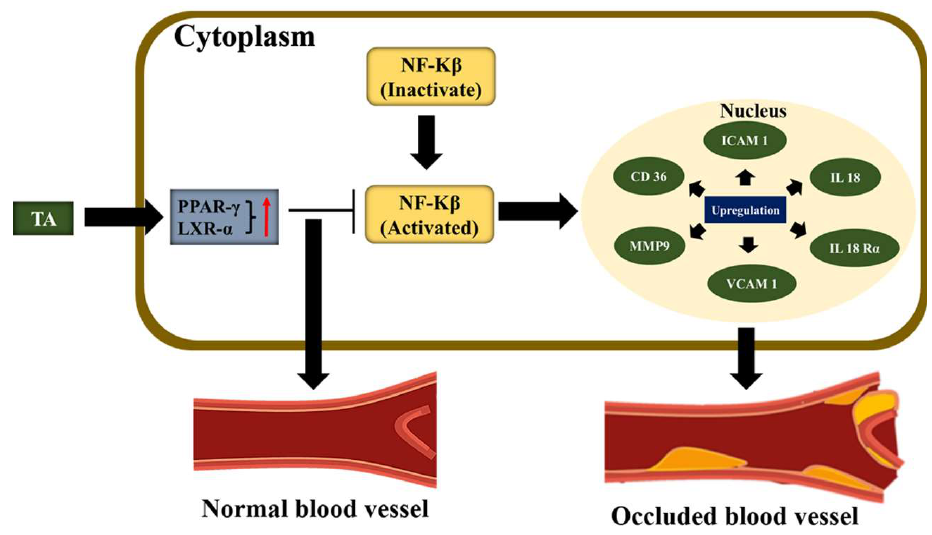
Figure 5. Schematic illustration of plausible mechanism behind the anti-atherosclerotic activity of TA extracts. The red arrow in the figure indicates the upregulation of nuclear receptors (PPAR-γ and LXR-α).